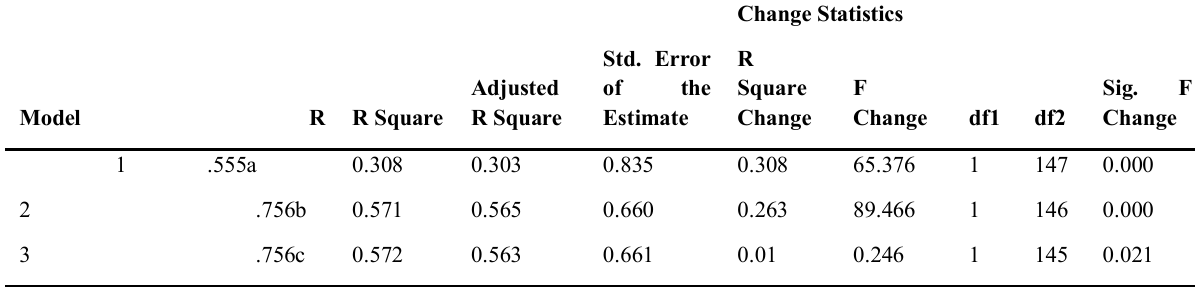
Table 7: Model Summary; MMR model on processes